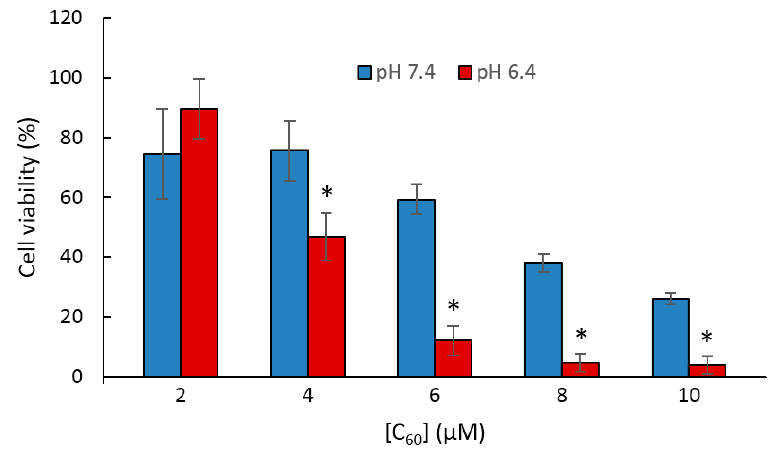
Figure 65. Cell viability of HeLa cells treated with C 60 - γ -CD-NH 2 after irradiation ( λ = 400–500 nm for 30 min). * p < 0.005 as compared to the PDT activity at pH 7.4. Adapted from Nobusawa; Akiyama; Ikeda; Naito [216].